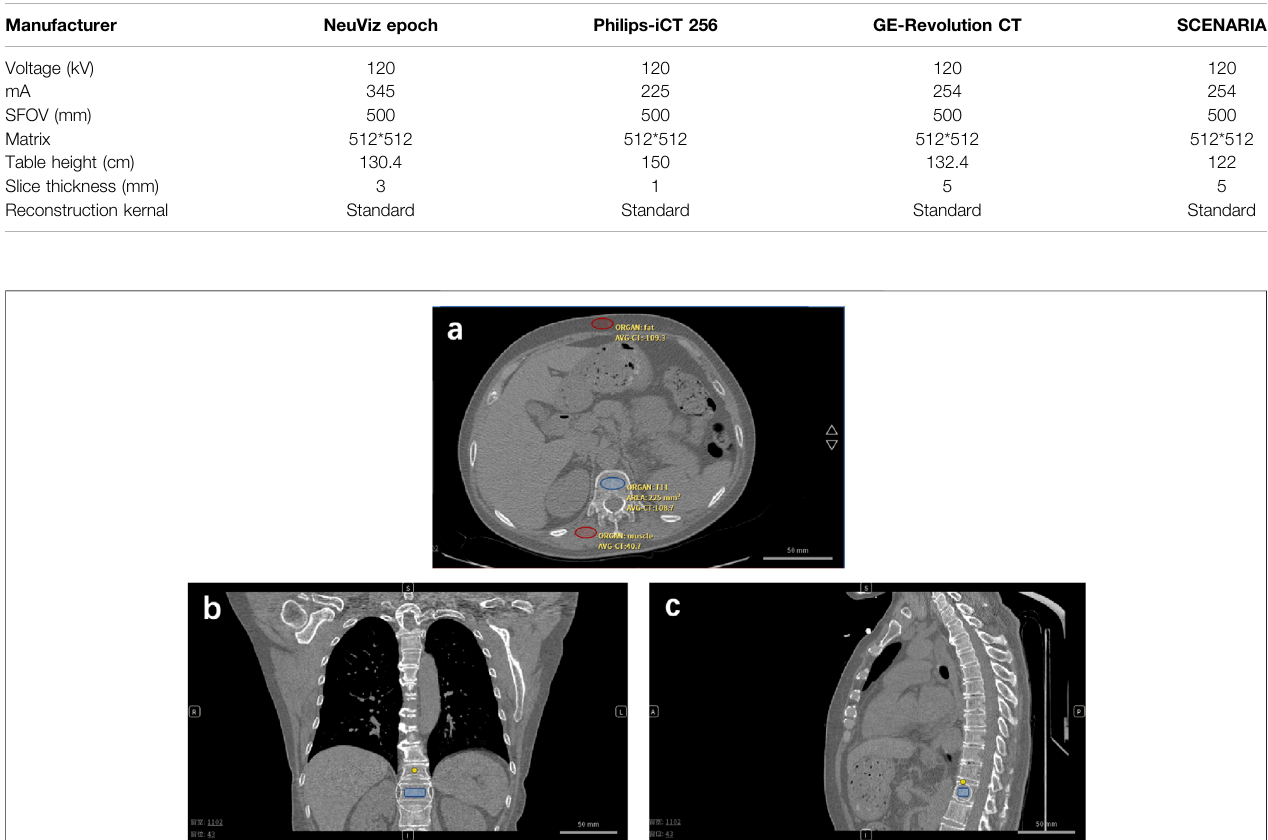
TABLE 2 | Low-dose CT scanning parameters.